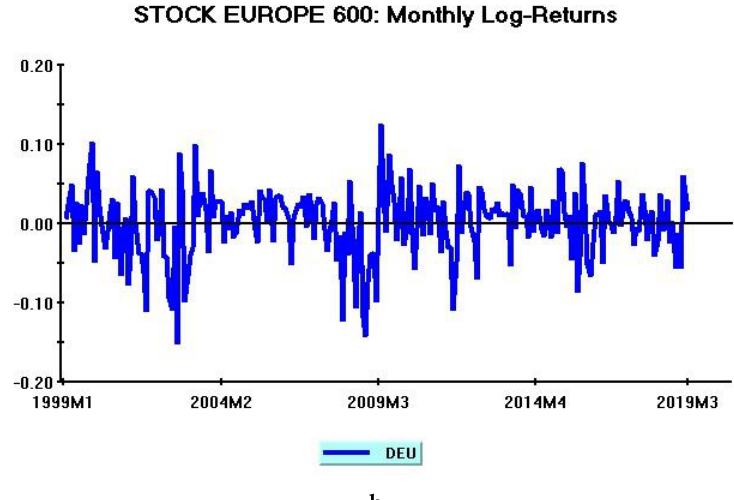
Figure 1. ( a ) SP500: Monthly Log-Returns; ( b ) STOCK EUROPE 600: Monthly Log-Returns.